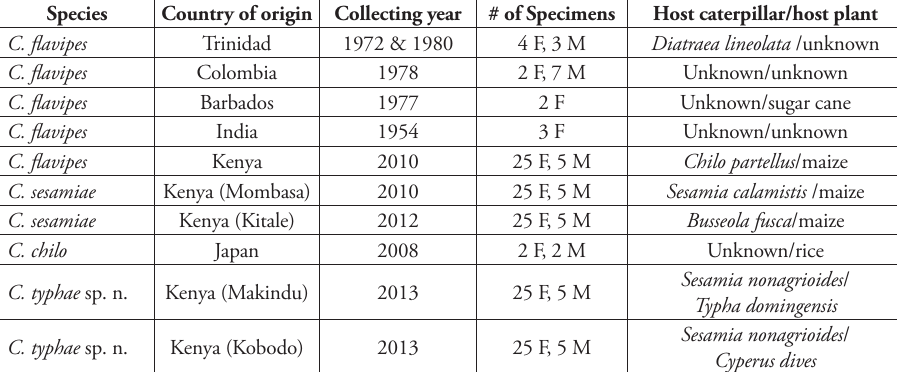
Table 1. Specimens studied for this paper. F- female specimen, M- male specimen.